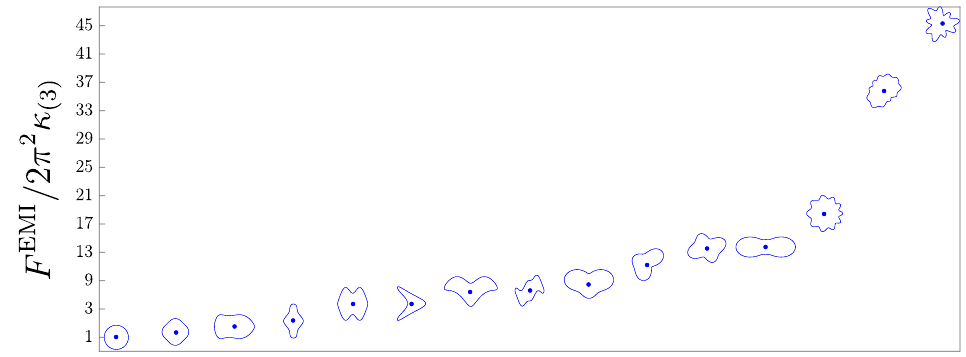
Figure 7 . We plot the entanglement entropy universal term normalized by the disk result for the EMI model for various entangling regions. Each data point corresponds to the entangling region dis- played on top of it. The shapes are arranged in a way such that F EMI grows as we move to the right. 71 . 3 κ , which is already very close ( ∼ 0 . 8% off). The match improves as e grows. For (3) instance, we have F EMI | (3.3) ’ 221 . 6 κ and F EMI | (4.4) = 221 . 2 κ ; F EMI | (3.3) (3) (3) e =0 . 999 e =0 . 999 e =0 . 9999